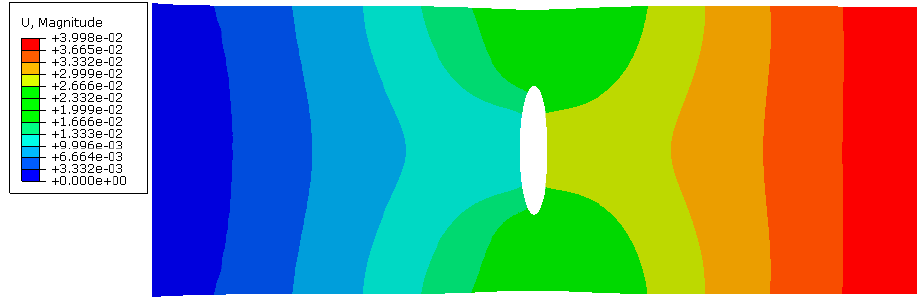
Figure 10. Distribution of strain with cracked components.